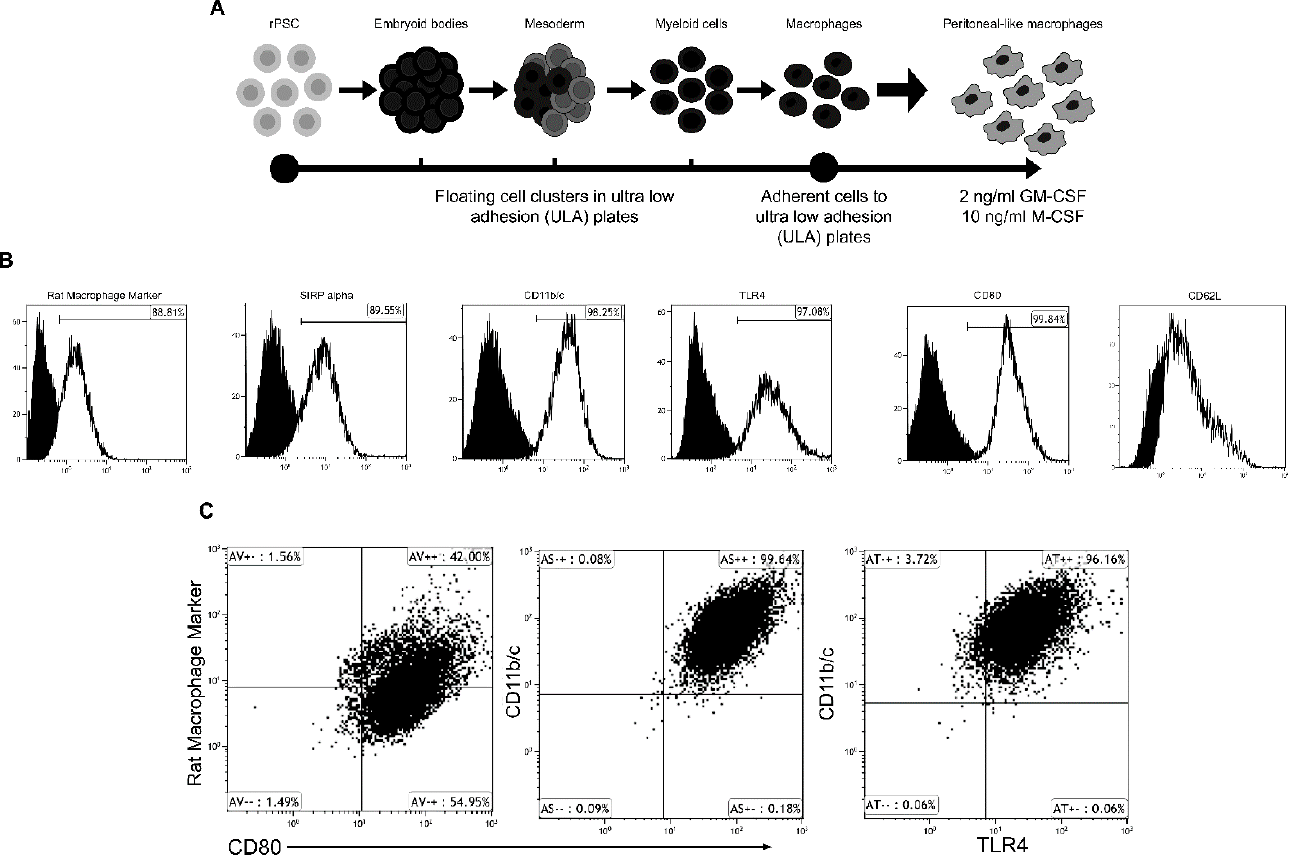
Figure 1. Characterization of embryonic-derived large “peritoneal-like” macrophages (Ed-LPMs). Panel ( A ) represents a schematic of Ed-LPMs derivation from rat embryonic stem cells. ED-LMPs were characterized by flow cytometry for known surface markers (Panel ( B , C )).